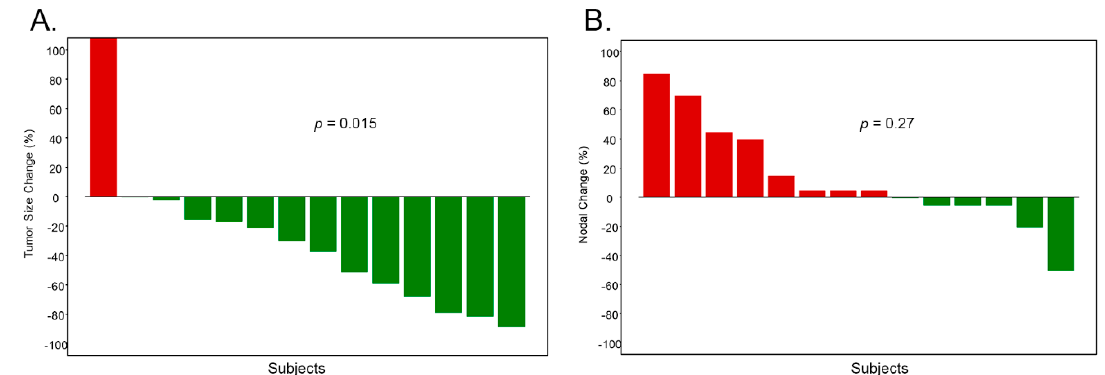
Figure 3. The standard-of-care treatments used in the study (ACT, TCHP, and TC) decreased the size of the tumors but did not change the percent of Nodal in the tumors. ( A ) There is a statistically significant decrease in the tumor size in response to the different standard-of-care treatments ( p = 0.015, Wilcoxon signed-rank test); while ( B ) there is a statistically insignificant change in the percent of Nodal in the tumors after treatment ( p = 0.27, Wilcoxon signed-rank test).